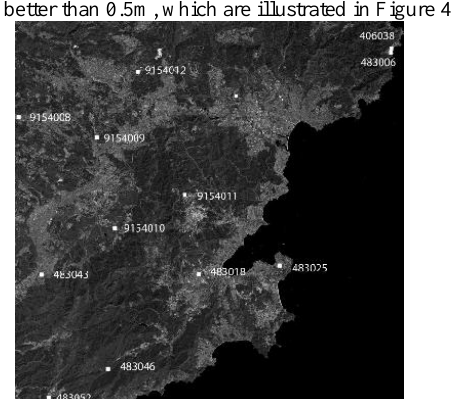
Figure 4. Location of CP in the ZY-3 image of Sainte-Maxime of France